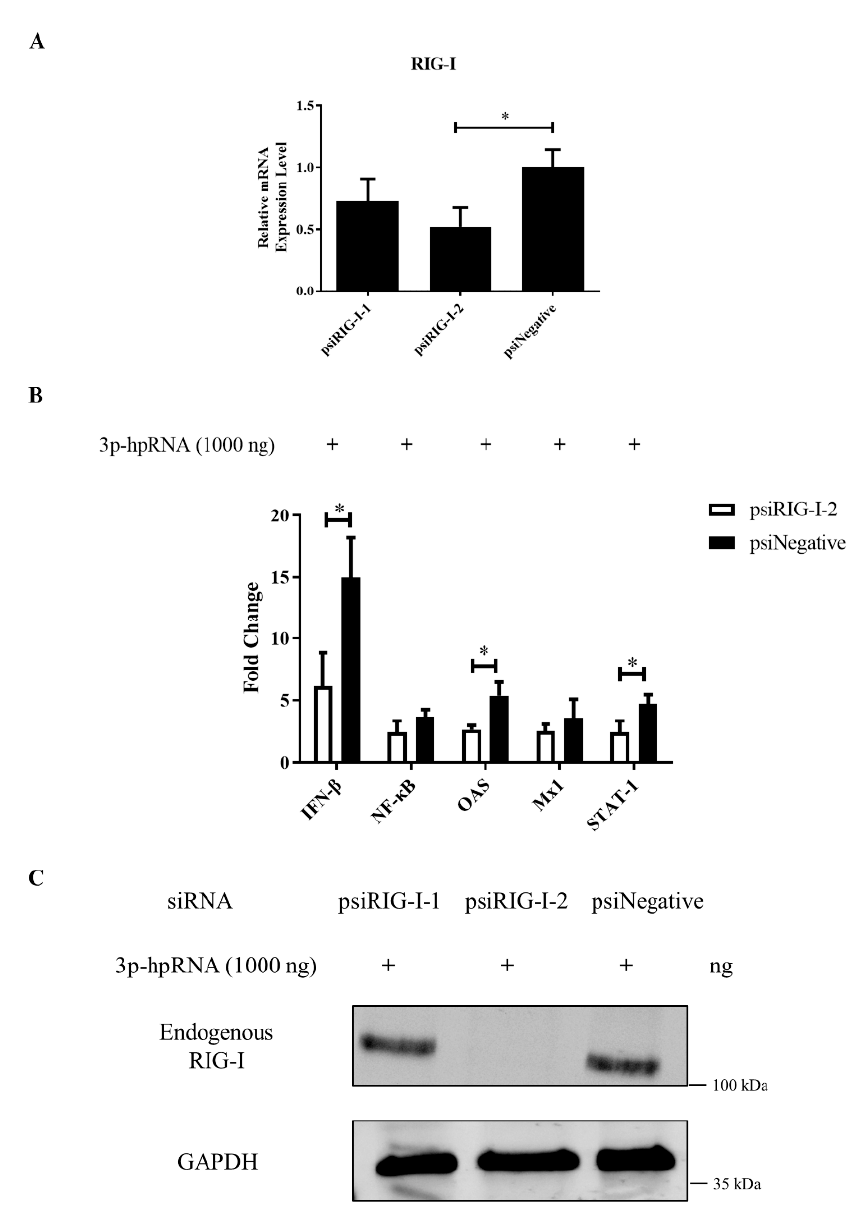
Figure 4. RIG-I knockdown suppresses the RIG-I–mediated antiviral response. ( A ) MDCK cells were transfected with 100 nmol of RIG-I siRNA or negative control. RIG-I mRNA expression level was evaluated by qRT-PCR 24 h after transfection. ( B ) MDCK cells were transfected with 100 nmol of psiRIG-I-2 and 1000 ng of the RIG-I agonist 3p-hpRNA to stimulate the antiviral response. NF- κ B, IFN- β , Mx1, OAS, and STAT-1 mRNA expression levels were evaluated by qRT-PCR 24 h after transfection and were normalized to the level of GAPDH mRNA. Samples were analyzed in triplicate and three independent experiments were performed. * p < 0.05 vs. empty vector control group. Error bars indicate standard deviation. ( C ) MDCK cells were transfected with indicated 200 nmol siRNA and 1000 ng RIG-I agonist 3p-hpRNA together. The whole cells protein was obtained after 24 h; the expression level of endogenous RIG-I was determined by western blotting with GAPDH used as a loading